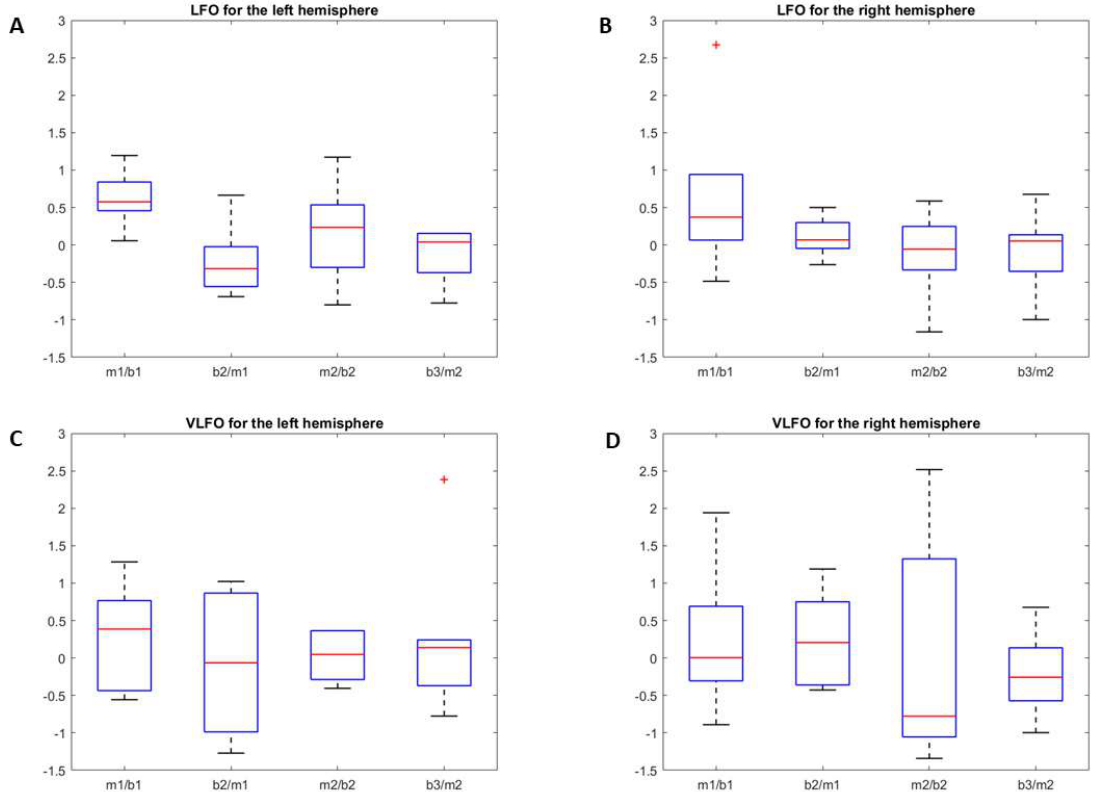
Figure 6. Boxplot showing, on the y -axis, the ratio of LFO power (low-frequency oscillation) and VLFO power (very-low-frequency oscillation) for O2HB. On the x -axis, the subsequent experimental blocks are shown: (m1/b1) from the first baseline to the first music period; (b2/m1) from the first music period to the second baseline; (b2/m2) from the second baseline to the second music block; (b3/m2) from the second music block to the third baseline. ( A ) Ratios of LFO power in the left hemisphere. After an increase in LFO power in m1/b1, a significant decrease is shown in b2/m1. ( B ) Ratios of LFO power in the right hemisphere. ( C ) Ratios of VLFO power in the left hemisphere. ( D ) Ratios of VLFO power in the right hemisphere. Table 1. LFO.Ratio between subsequent pairs of experimental blocks, for O2Hb (top) and HHb (bot- tom), for the left hemisphere (left column) and the right hemisphere (right column), for each of the six subjects. Pairwise comparison between LFO.Ratio obtained in the subsequent couples of exper- imental blocks was performed with Wilcoxon signed rank test; p values are reported between each couple of columns. (m1/b1) from baseline to the first music block; (b2/m1) from the first music block to the second baseline (m2/b2) from the second baseline to the second music block; (b3/m2) from the second music block to the third baseline. Rs = rank statistic. O2Hb